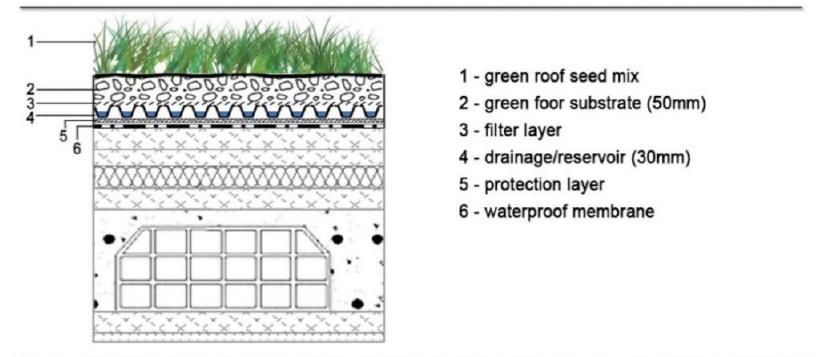
Figure 8. Roof covering with the addition of an intensive green roof.